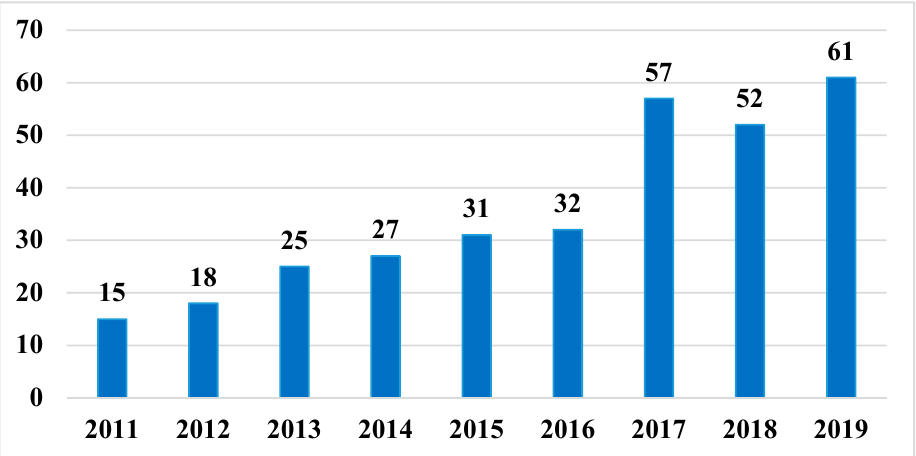
Figure 2. Number of publications from 2011 to 2019.